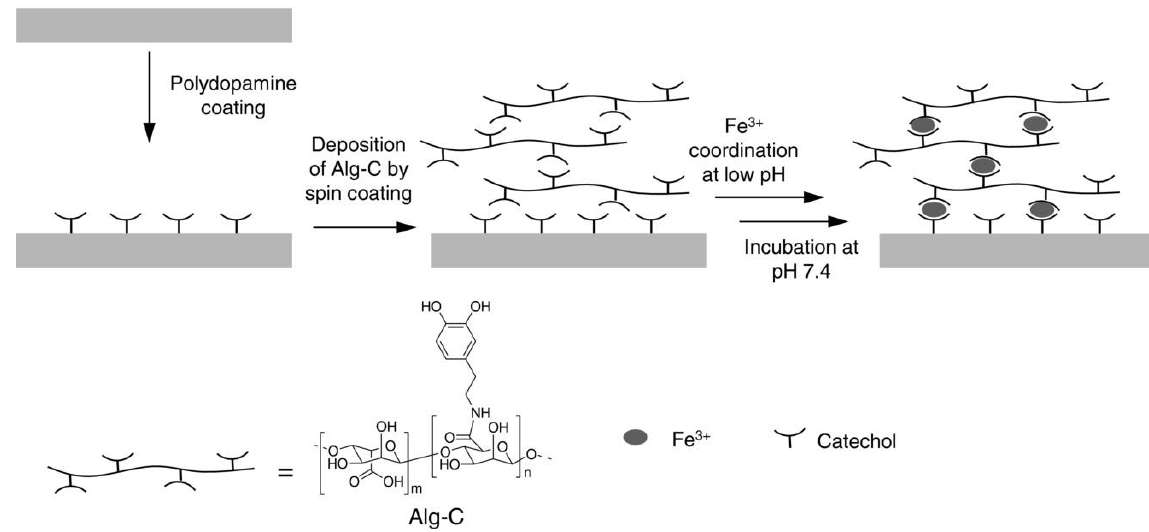
Figure 5. Alg-C/Fe 3+ coating. Catechol-Fe 3+ -catechol interactions are the bridge to construct the antimicrobial multilayer film. Reprinted with permission from reference [74], copyright 2016 Wiley.